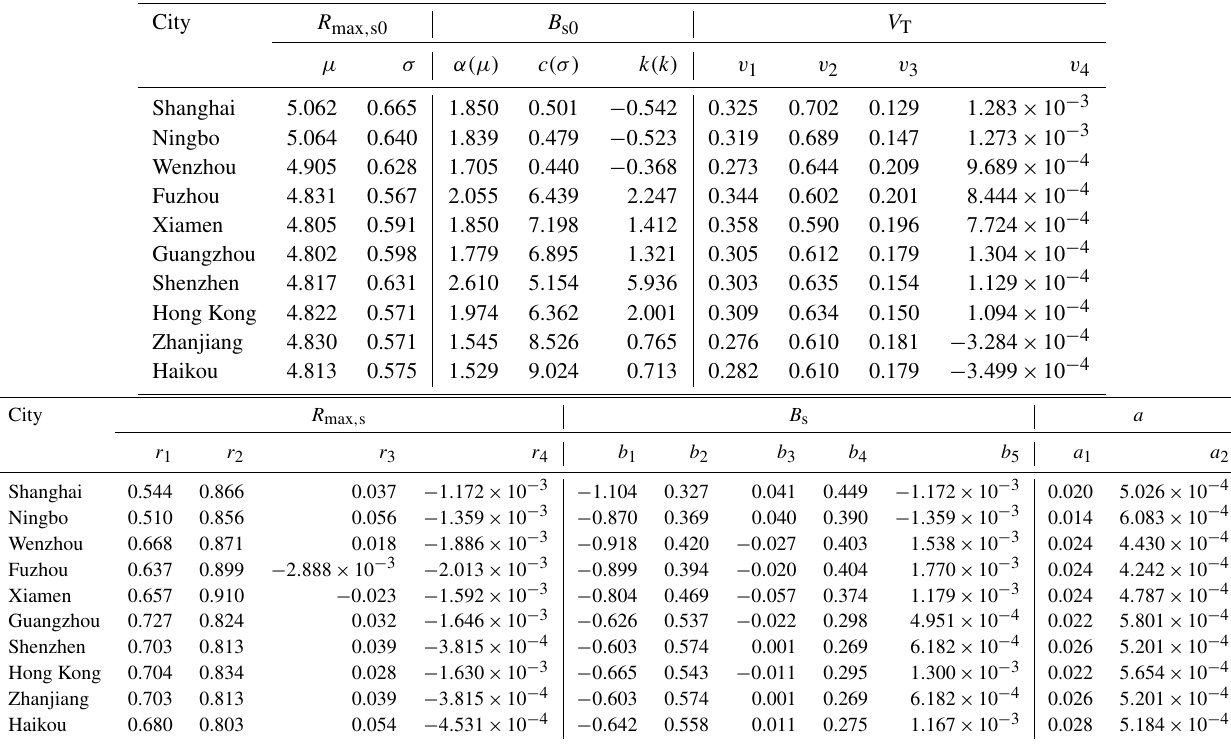
Table 3. Coefficients of PDFs and recursive models for wind field